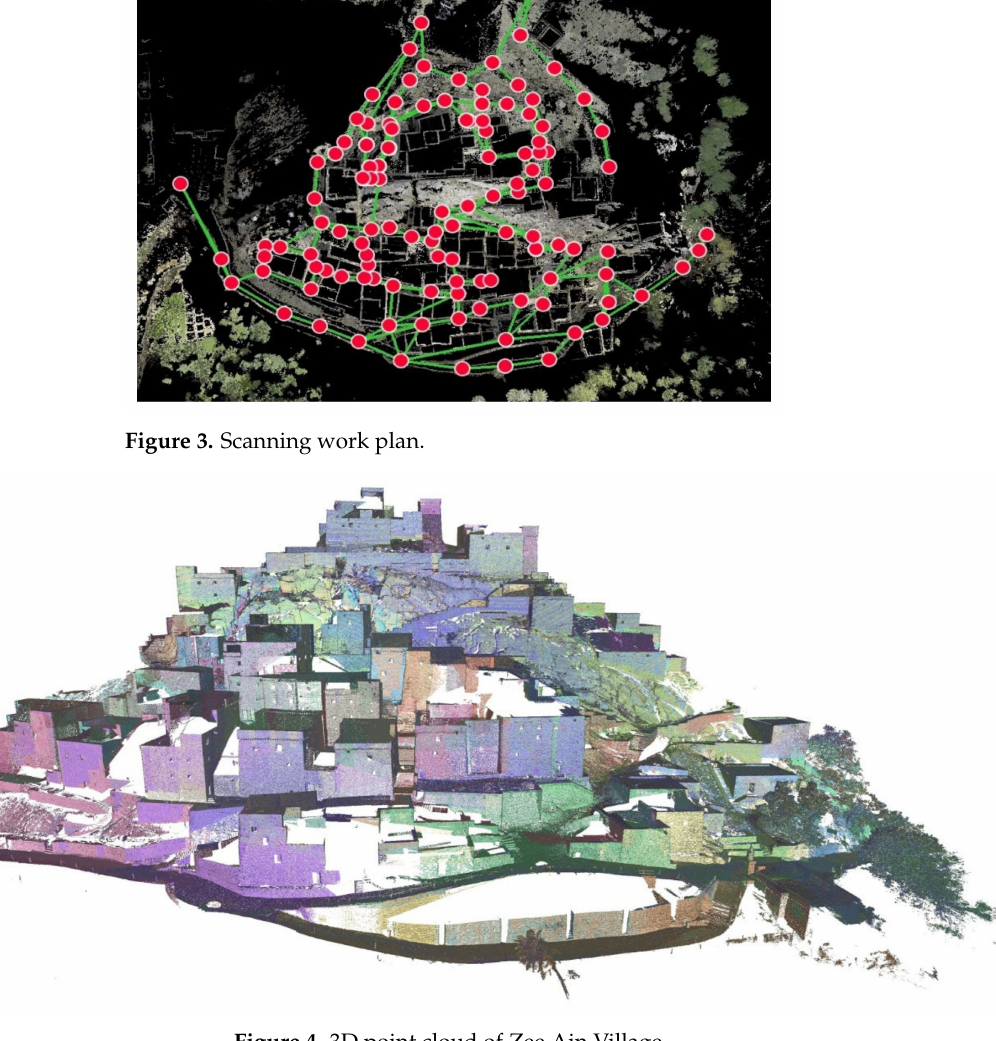
Figure 4. 3D point cloud of Zee Ain Village.